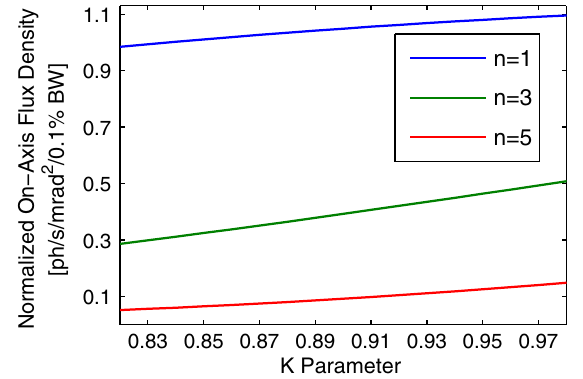
TABLE I. Specifications of the CPMU prototype